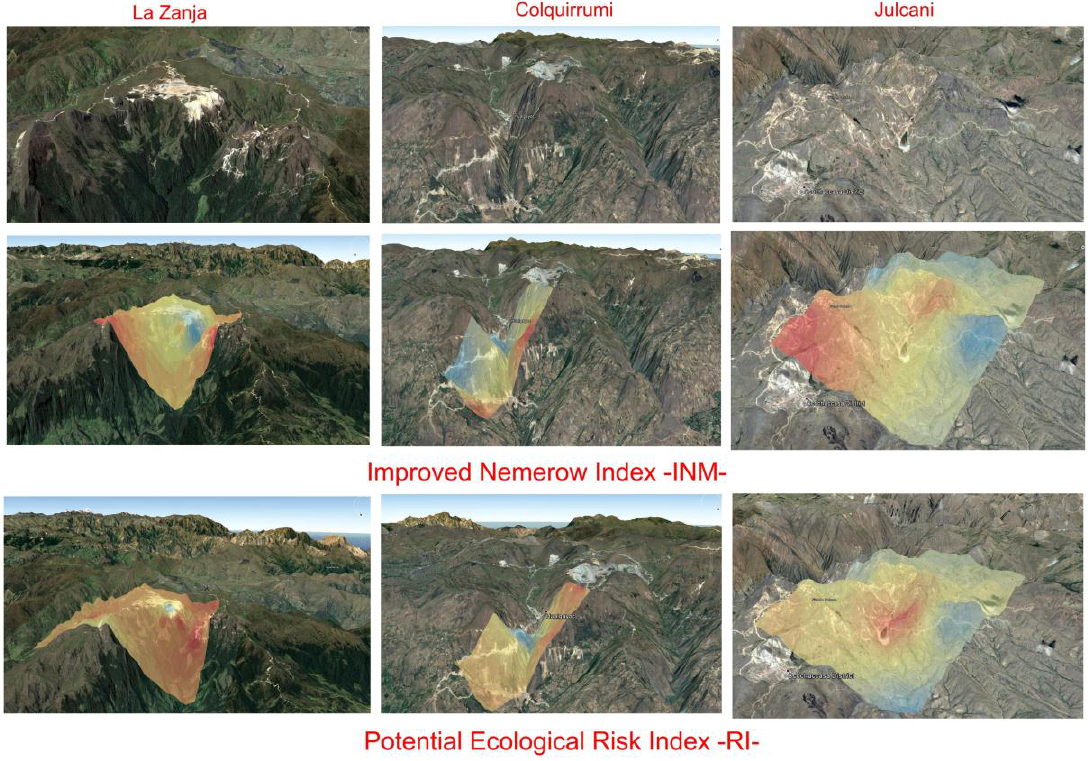
Figure 6. Spatial distribution of the improved Nemerow index (I IN ) and the potential ecological risk index (RI).